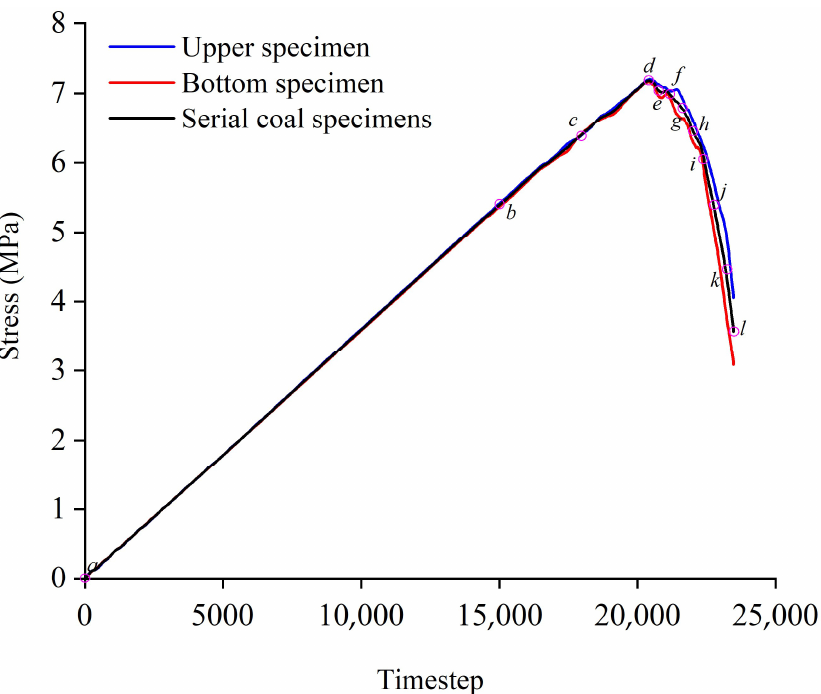
Figure 11. Quantitative relationship between the stress and timestep of serial coal pillar specimens. Figure 11 presented the quantitative stress-time relationship of upper testing specimen, bottom testing specimen and serial coal pillar specimens, which were expressed as the blue curve, red curve and black curve. Figure 12 represents the contact force chain distribution of serial coal pillar specimens during the loading process. The step in Figure 12 was corresponding to the purple time circle in Figure